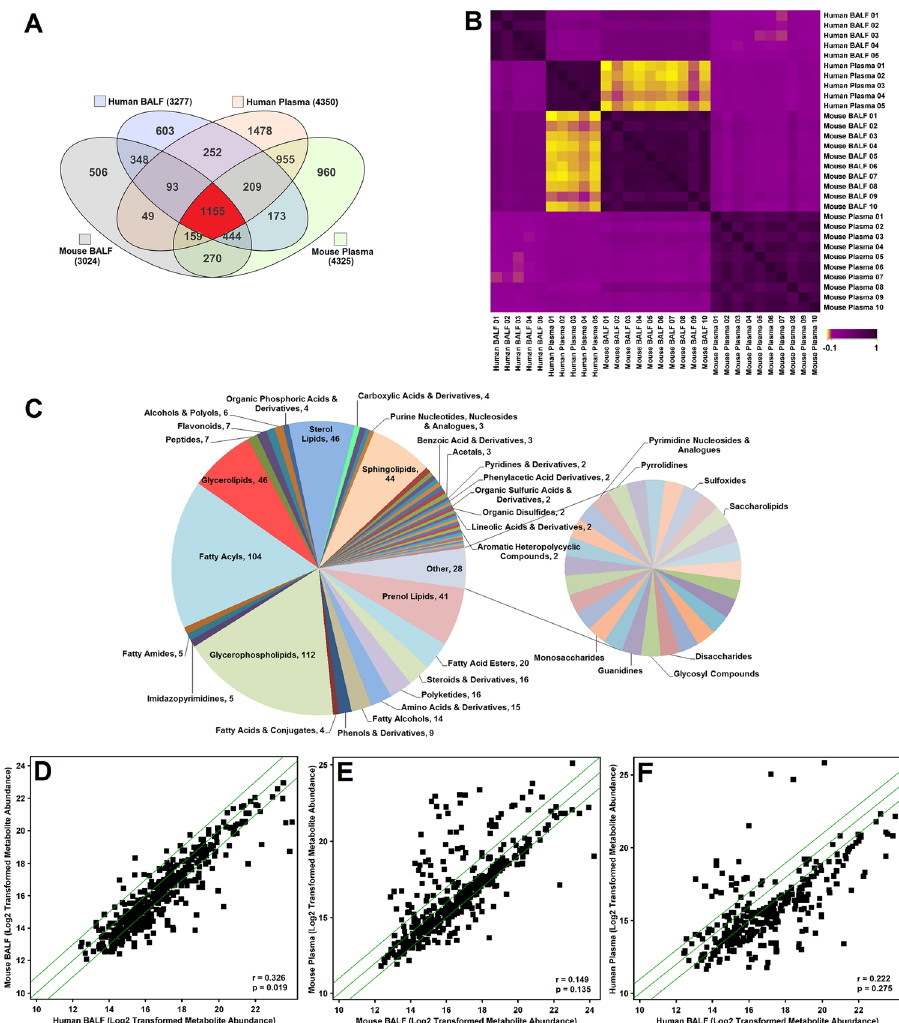
Figure 1. Metabolite relationships across species and biofluids. ( A ) Overlap of metabolites represented with a venn diagram of metabolites identified in both aqueous and lipid fractions filtered for presence in at least 2 samples within each group. ( B ) Spearman correlation matrix of species and biofluid based on detected lipids in the samples, with yellow (r = − 0.1) representing a negative correlation, and purple (r = 1) representing a positive correlation. ( C ) Distribution of biochemical classes represented by metabolites that were detected in human and mouse, BALF and plasma (1155) from Fig. 1A. Classes were based on Lipid Maps and HMDB classifications. The number of metabolites corresponding to the overlap is indicated next to the name of the class. ( D ) Scatter plot showing a positive correlation in metabolites between mouse BALF and human BALF. ( E ) Scatter plot showing a positive correlation in metabolites between mouse plasma and mouse BALF. ( F ) Scatter plot showing a positive correlation in metabolites between human plasma and human BALF. In the scatterplots, each square represents an individual metabolite. The metabolites along the diagonal green lines show the strongest positive correlations. The average abundance of each metabolite is scaled between 10 and